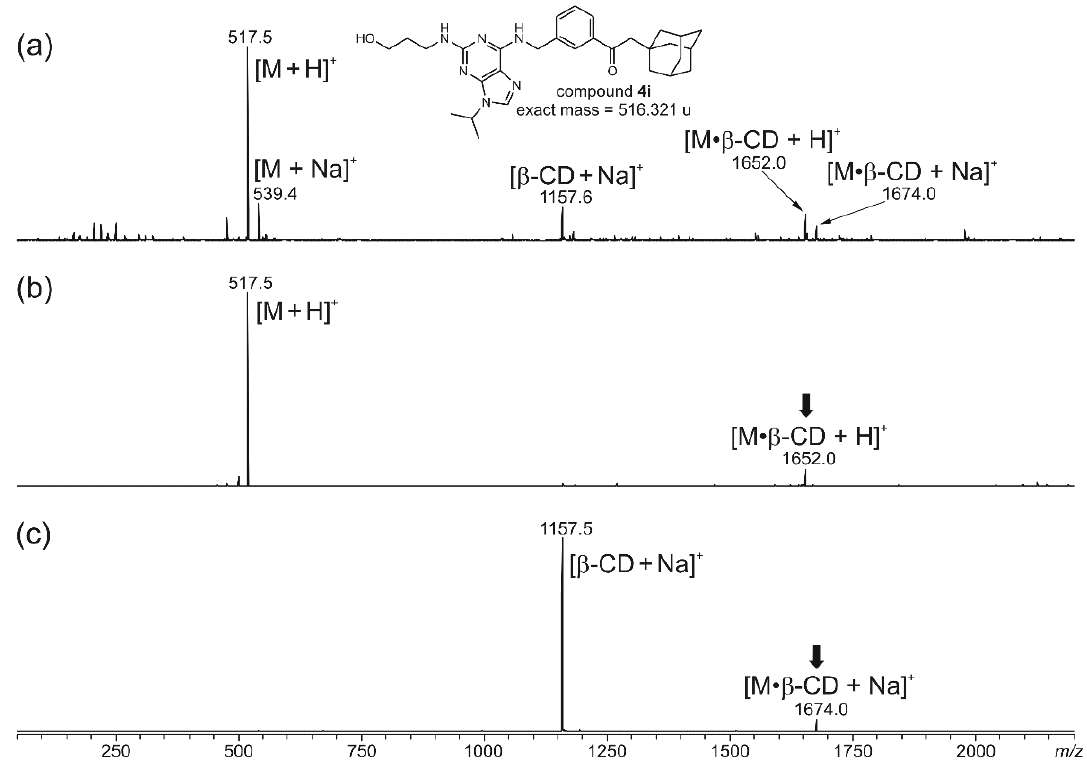
Figure 2. The positive-ion ESI mass spectra of the MeOH/H 2 O (1/1, v / v ) solution of 4i · β -CD: ( a ) first-order mass spectrum, ( b ) MS/MS of m / z 1652, ( c ) MS/MS of m / z 1674. The assignments for the observed ions are shown in the brackets. The fragmented ions in tandem mass spectra are marked with bold downward arrows.